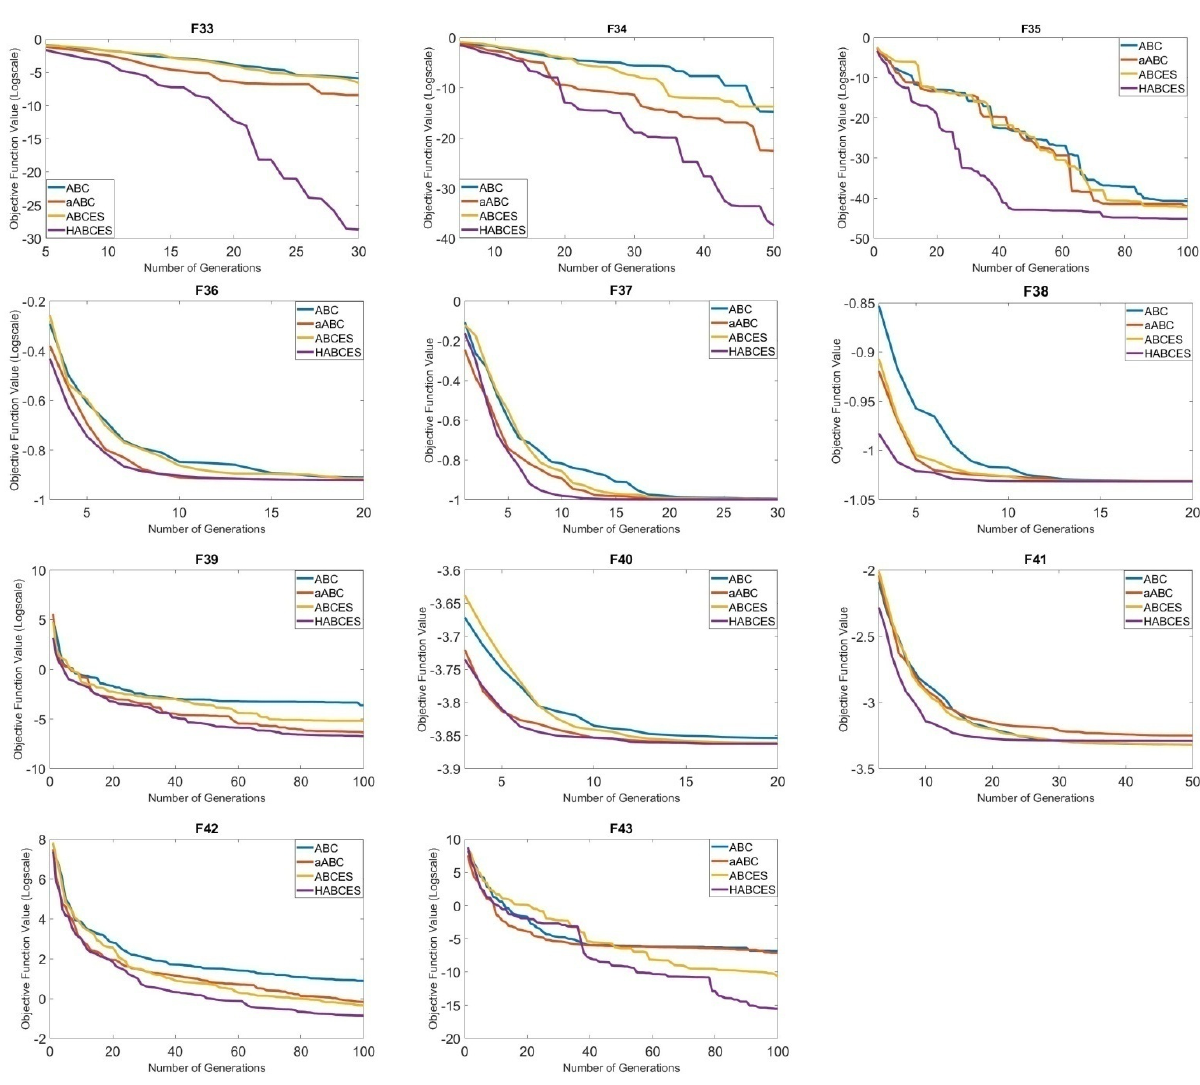
Figure 4. Comparison of the convergences of the ABC, aABC, ABCES and HABCES algorithms in solving low-dimensional global optimization problems (F33–F43).